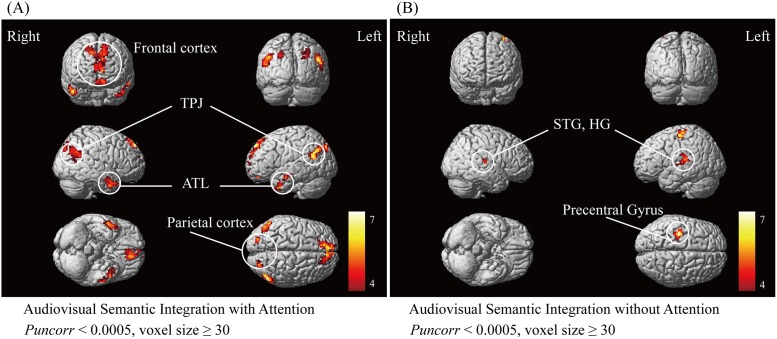
(A) The fMRI activation observed in contrast of (AV+Fn) > (An+Vn) presented on the attended side, reflecting the cortical network of semantic integration with attention. (B) The fMRI activation observed in contrast of (AV+Fn) > (An+Vn) presented on the unattended side, reflecting the cortical network of semantic integration without attention. Puncorr < 0.0005, cluster voxels ≥ 30 voxels. TPJ, temporoparietal junction; ATL, anterior temporal lobe; STG, superior temporal gyrus; HG, Heschl’s gyru. The color bar indicates T values.